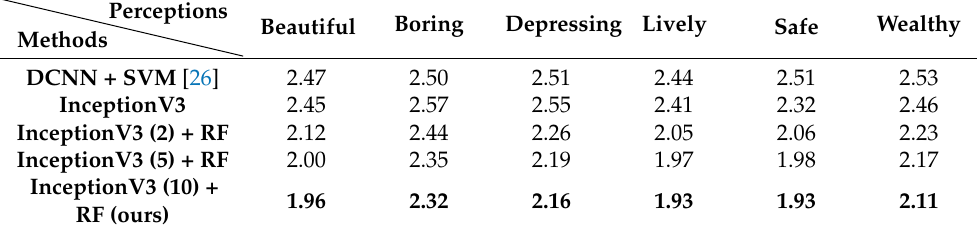
Table 7. Performance of the perception models